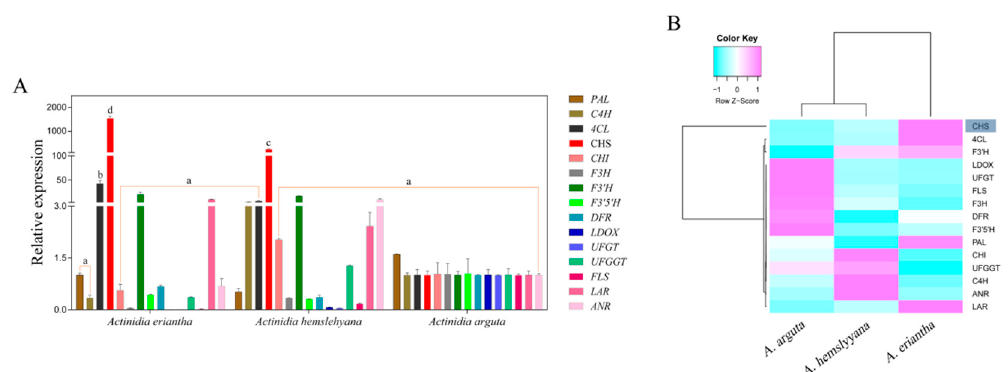
Figure 4. Expression profiles of structural genes in three Actinidia species including A. eriantha , A. hemsleyana , and A. arguta ( A ), and cluster analysis of gene expression ( B ). Data are means ± SE of three replicates. Error bars represent standard error of the means. Columns with di ff erent lowercase letters are significantly di ff erent at P ≤ 0.05. Cyan and pink boxes with normalized color scales from -1 to 1 indicate low and high expression level, respectively. The blue shadow indicates that CHS gene is clustered into a single group. Table 2. Correlation analysis between content of anthocyanin components precursors and expression level of fifteen genes involved in anthocyanin biosynthesis. Anthocyanins and Precursors